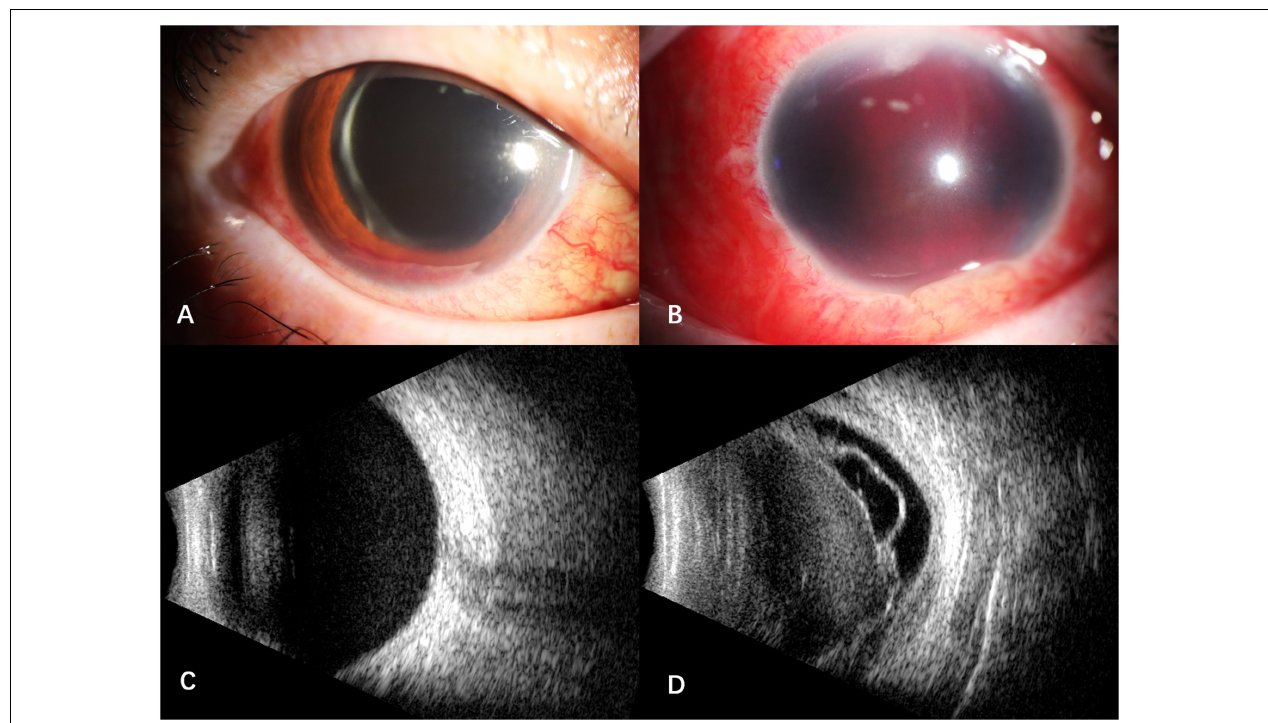
FIGURE 1 | Anterior segment and B -scan ultrasonography of the patient after the fourth intravitreal MTX combined with paracentesis. (A) floating blood cells and a small amount of hyphema in the anterior chamber of the right eye; (B) the anterior chamber was full of blood in the left eye; (C) suspected vitreous hemorrhage in the right eye; (D) suspected vitreous hemorrhage with retinal detachment and proliferative membrane in the left eye.